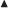
Microbial composition and diversity analysis in caecal inocula and reactor effluents of model 5 and 5∗. (A,B) Principle Coordinate Analysis (PCoA) of caecal inocula and reactor microbiota based on unweighted (A) and weighted (B) UniFrac analysis matrix on OTU level. Each point represents a microbiota sample from murine caecal content used as inoculum for model 5 (red ) and model 5∗ (blue ) or from stabilized reactor effluents of model 5 (orange ) and model 5∗ (green ). (C) Alpha diversity measured by Shannon diversity index and observed species. The box depicts distribution of diversity index for caecal inocula and fermentation samples. Boxes represent the interquartile range (IQR) between the 5th and 95th percentiles, respectively. (D,E) Microbial composition in caecal samples of WT C57BL/6 mice obtained by 16S rRNA amplicon sequencing. Relative abundance at phylum and family level of caecal inocula and fermentation samples of model 5 and 5∗. Data are mean ± SD. Values < 1% are summarized in the group «Others».